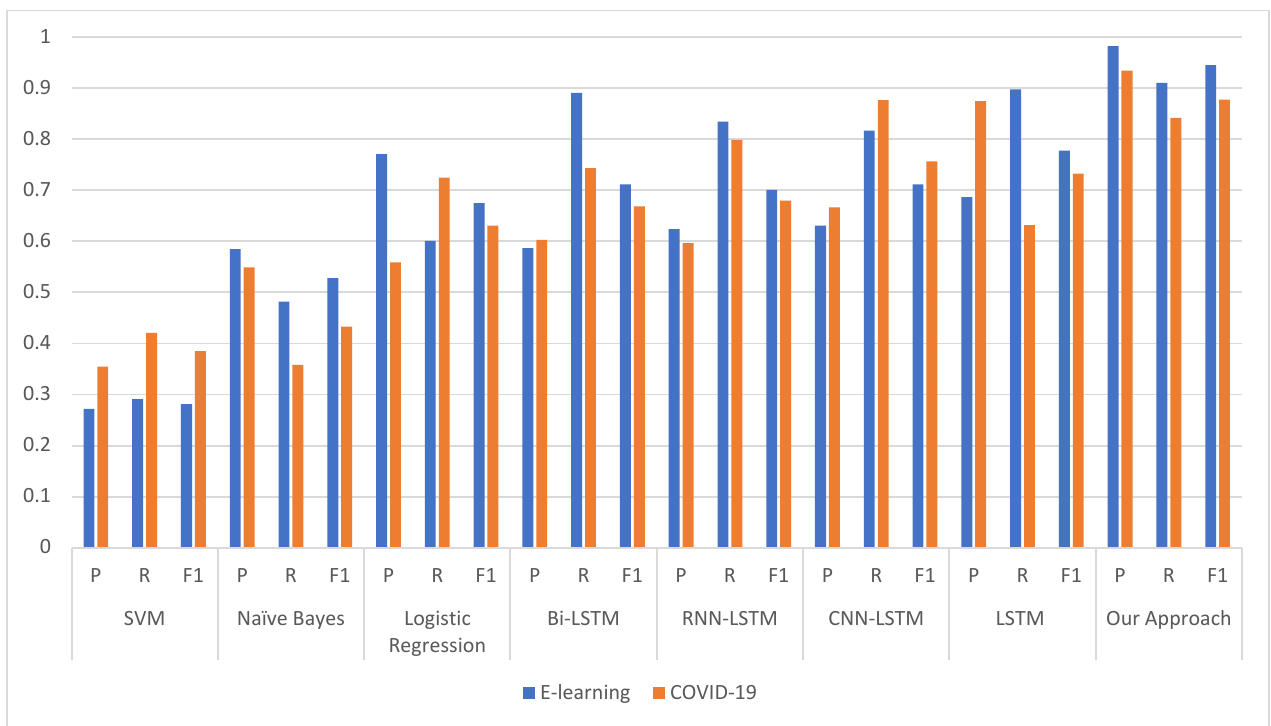
Figure 8. Performance statistics based on the comparison between (SA-CD19-EL) and other methods, using Precision (P), Recall (R), and F1 measures (F1).